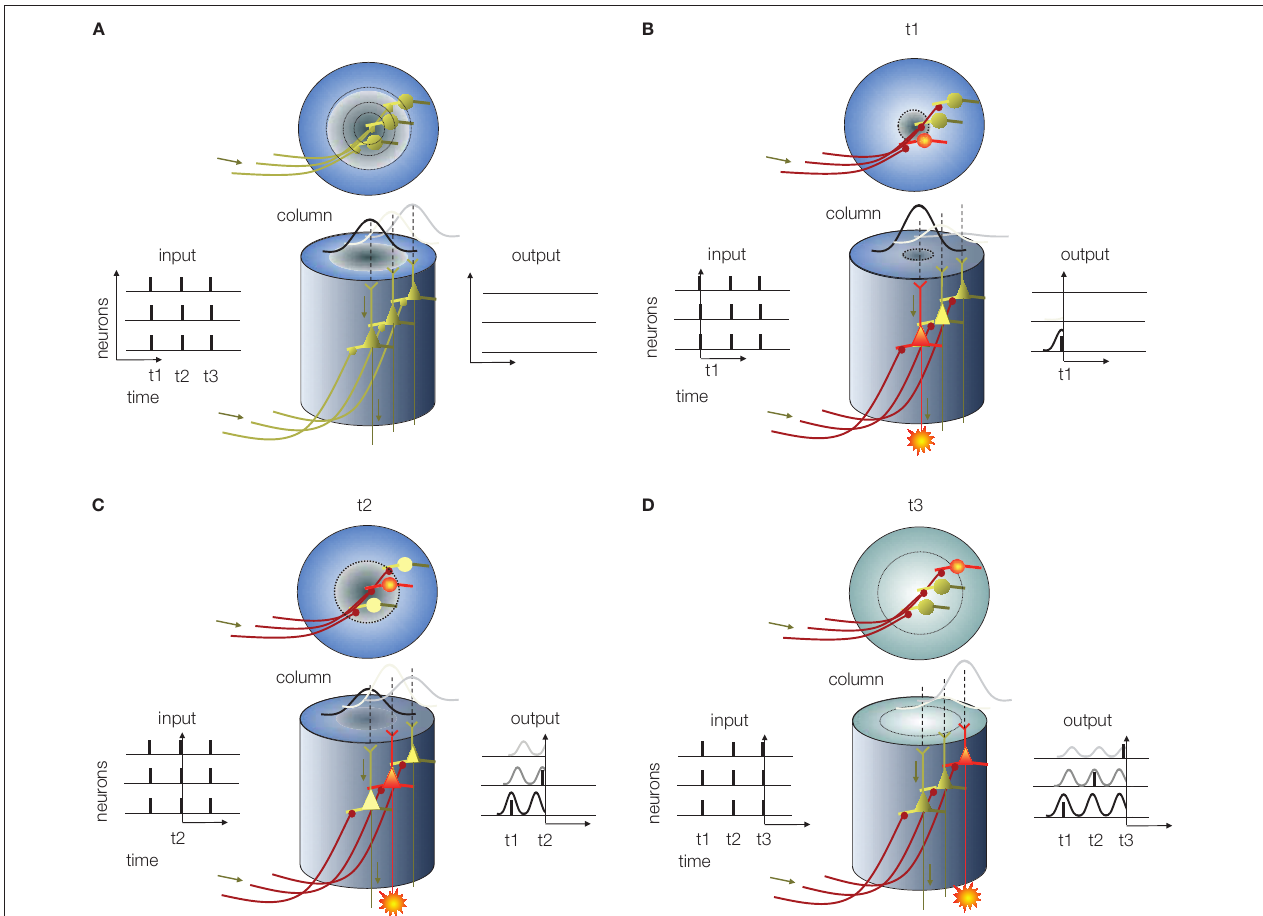
AP volley arrives ( t2 ). Again, the input APs depolarize all the neurons. However, the only neuron capable of generating an AP is the one near peak SMO. Since the only neuron at peak SMO is the second neuron, located farther from the center, this neuron will generate an AP while the first is in the refractory